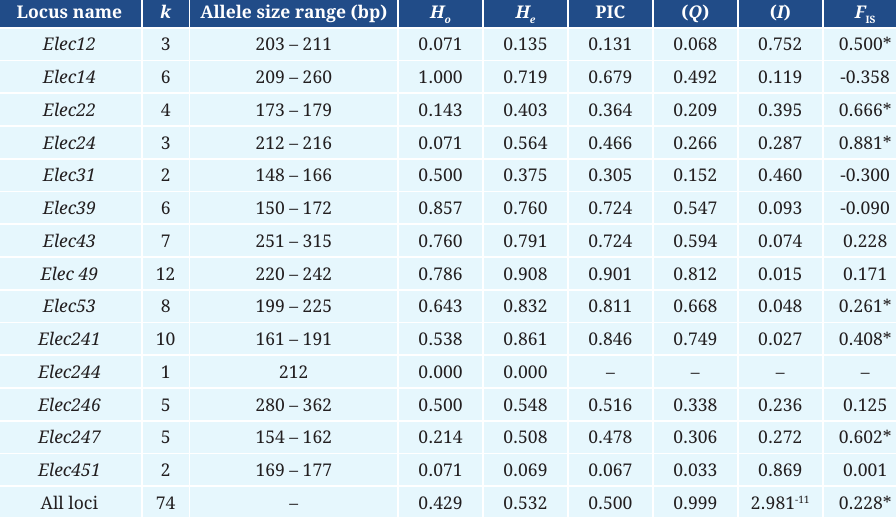
TABLE 2 | Cross-amplification of 14 microsatellite loci and genetic diversity per locus in Electrophorus = observed heterozygosity, H = expected voltai . Flanking primers, k = number of alleles, H o e heterozygosity estimated from 14 individuals, Q = paternity exclusion probability, I = probability of genetic identity, F = endogamy coefficient, PIC = polymorphic information content. * Significant value IS for the endogamy coefficient ( F IS